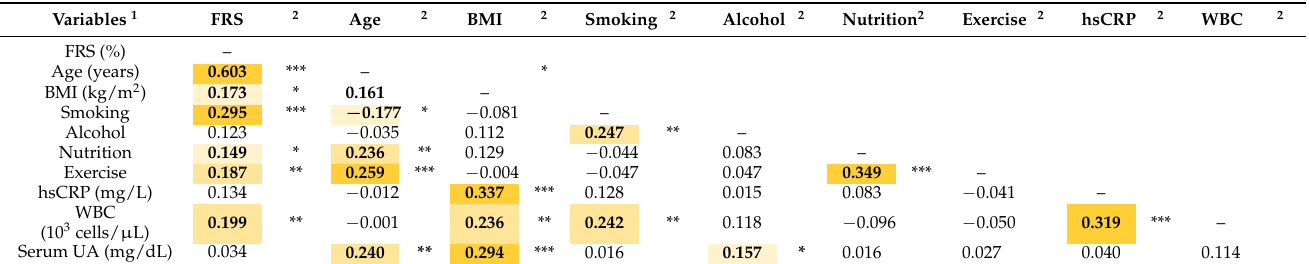
Table 2. Crude correlations between FRS, age, BMI, health-related lifestyle, and CVD risk markers in male workers. Variables 1 FRS